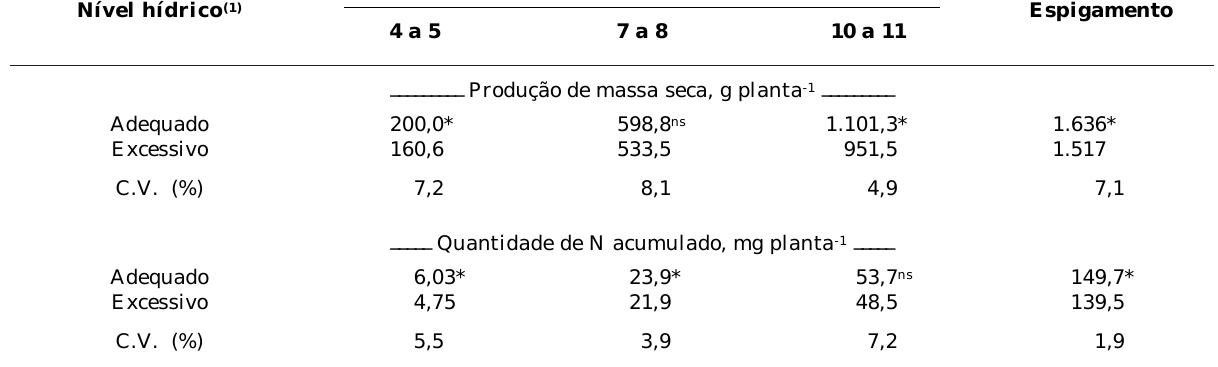
Quadro 2. Produção de massa seca e quantidade de nitrogênio acumulado na parte aérea da planta